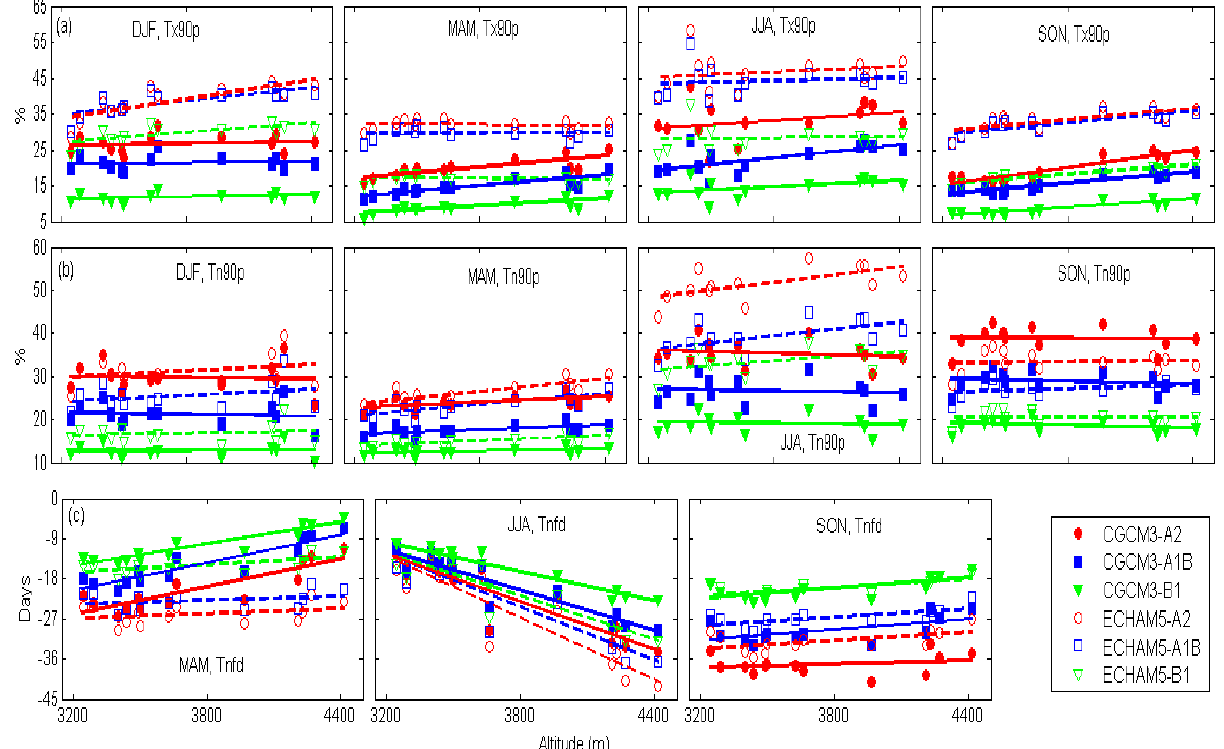
Fig. 7. As in Fig. 6, but for the frequency-related indices.